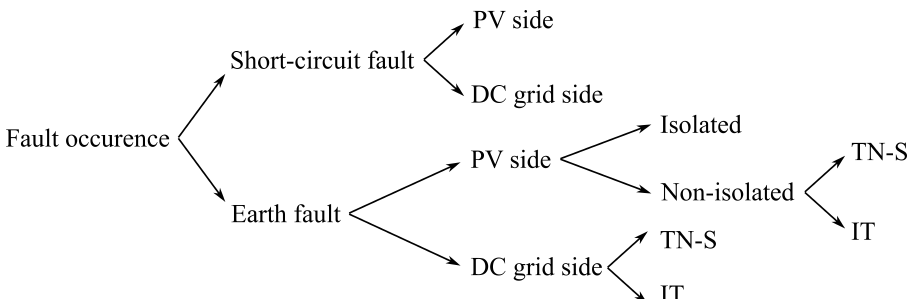
Figure 5. An overview of the possible faults in a fault tree structure. A distinction is made between short-circuit and earth faults and the input (PV) versus the output (DC grid) side of the